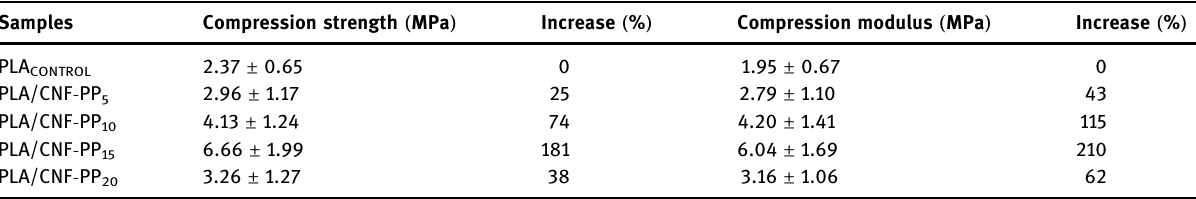
Table 4: Mechanical properties of PLA sca ff olds with di ff erent CNF contents